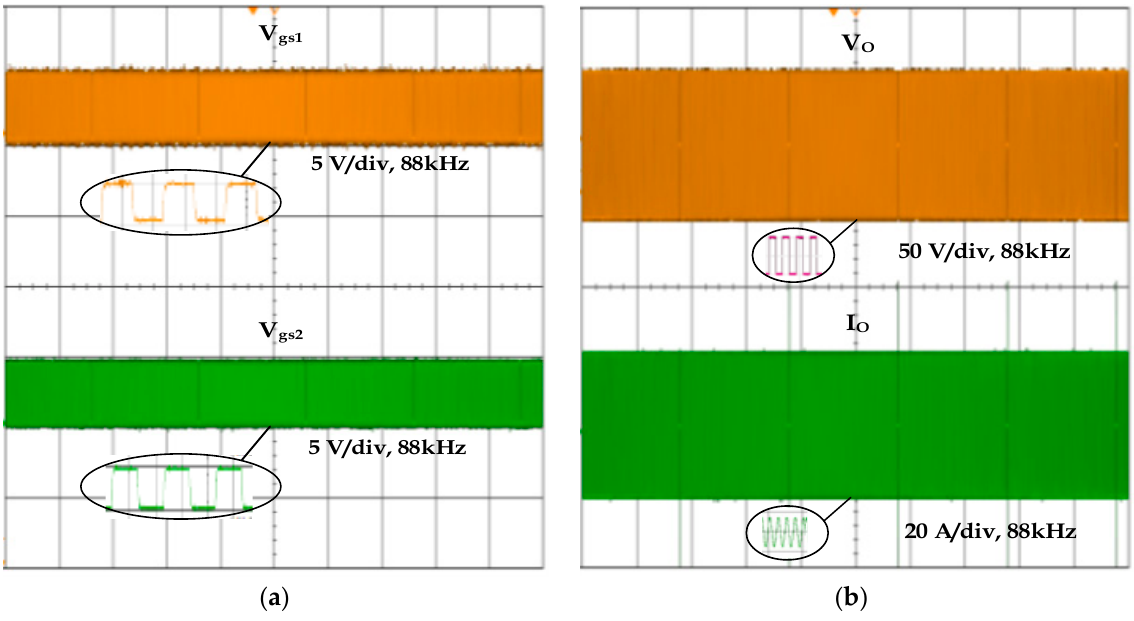
Figure 11. Experimental waveforms of Mode 1 with 100% PDM: ( a ) switching pulses and ( b ) output voltage and current.